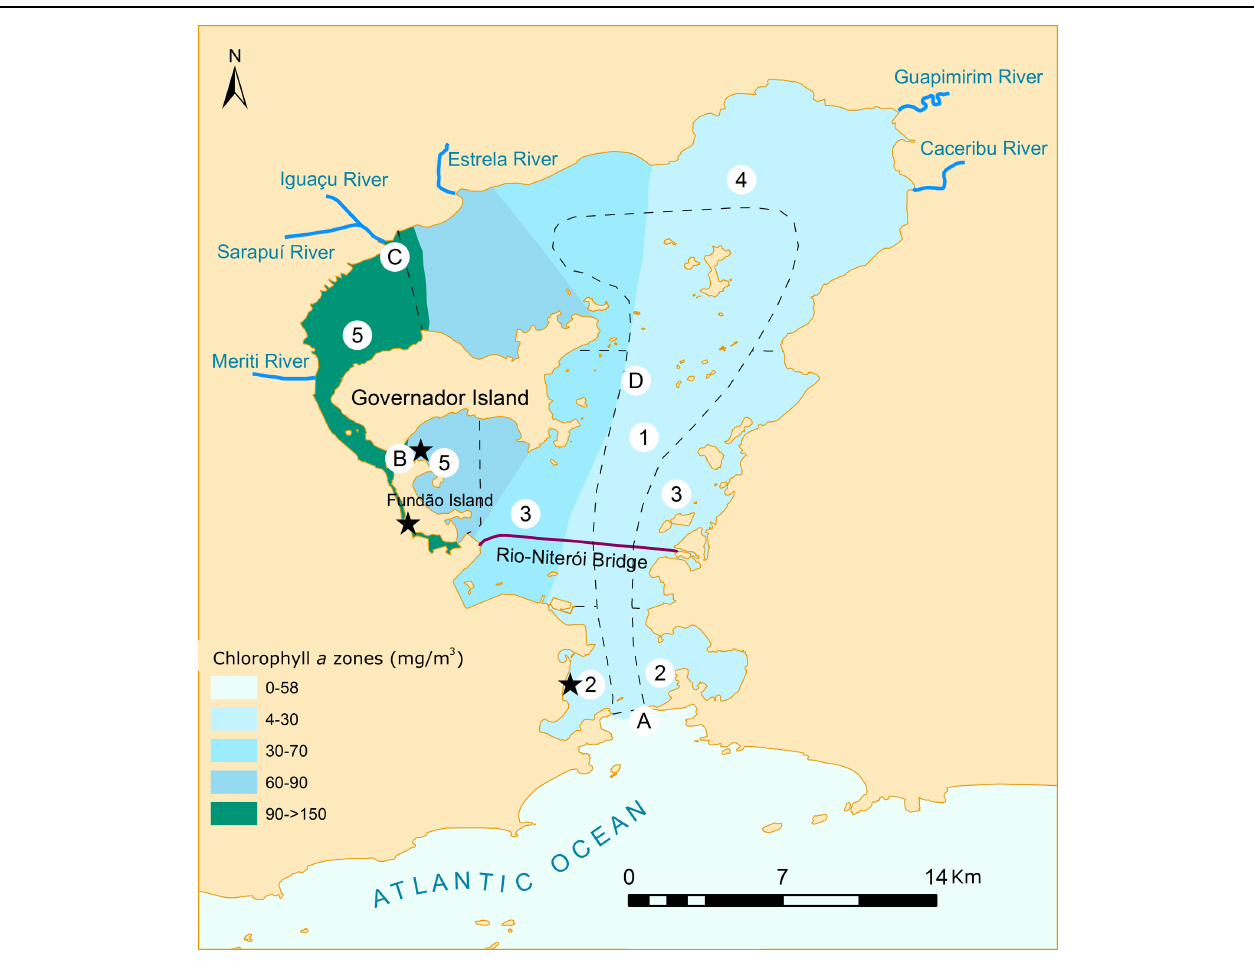
FIGURE 3 | Map of Guanabara Bay showing different parameters that indicate water quality throughoutthe sampling points (A–D) cited in the text. Sites where resistant bacteria were found are marked with a star ( ★ ), according to Coutinho et al. (2014). The bay was divided in sections (1–5, dashed lines) of various water quality levels (according to Mayr et al., 1989): section 1. better water quality conditions; section 2. areas with high circulation, but subjected to high organic load; section 3. deteriorated areas under strong influence of urban and industrial contaminants; section 4. areas under the influence of less polluted rivers and that still maintain a fringe of mangrove; section 5. the most deteriorated areas with low circulation and high input of contaminants. Water quality zones show a good correspondence with chlorophyll a (Chla) concentrations recorded in the literature (Mayr et al., 1989; Paranhos et al., 1998; Paranhos et al., 2001; Santos et al., 2007) which are shown here by different